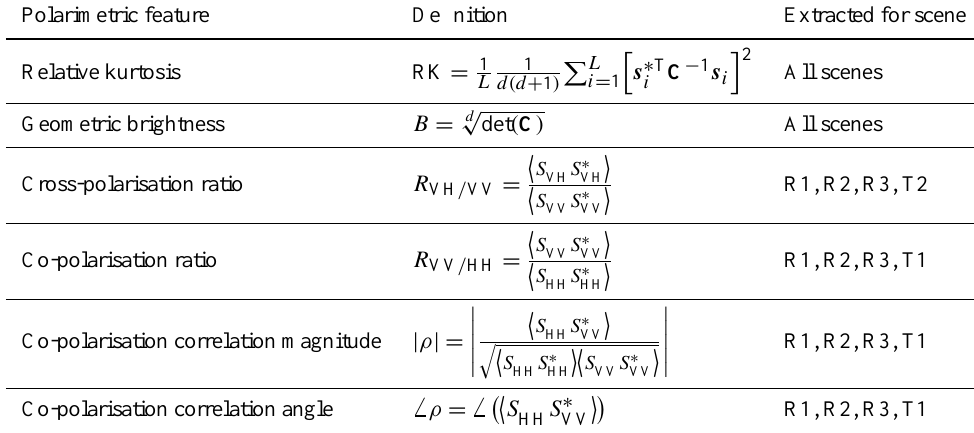
Table 3. Polarimetric SAR features included in the study. Polarimetric